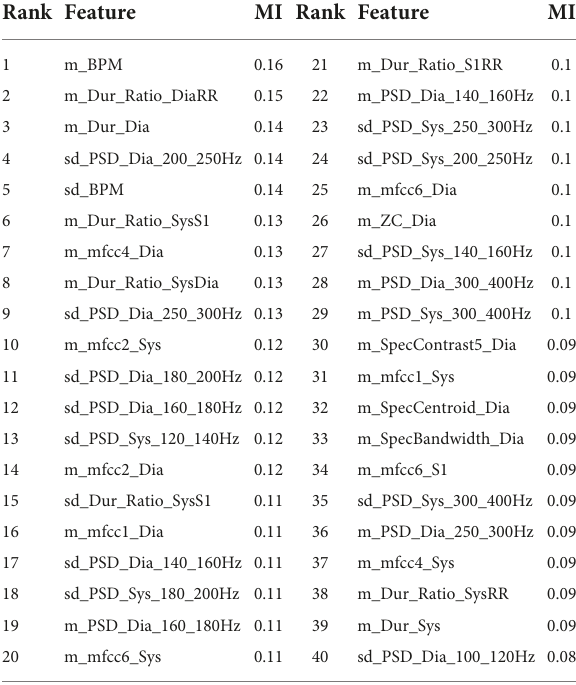
TABLE 7 Top 40 best predictor features according to their mutual information with the